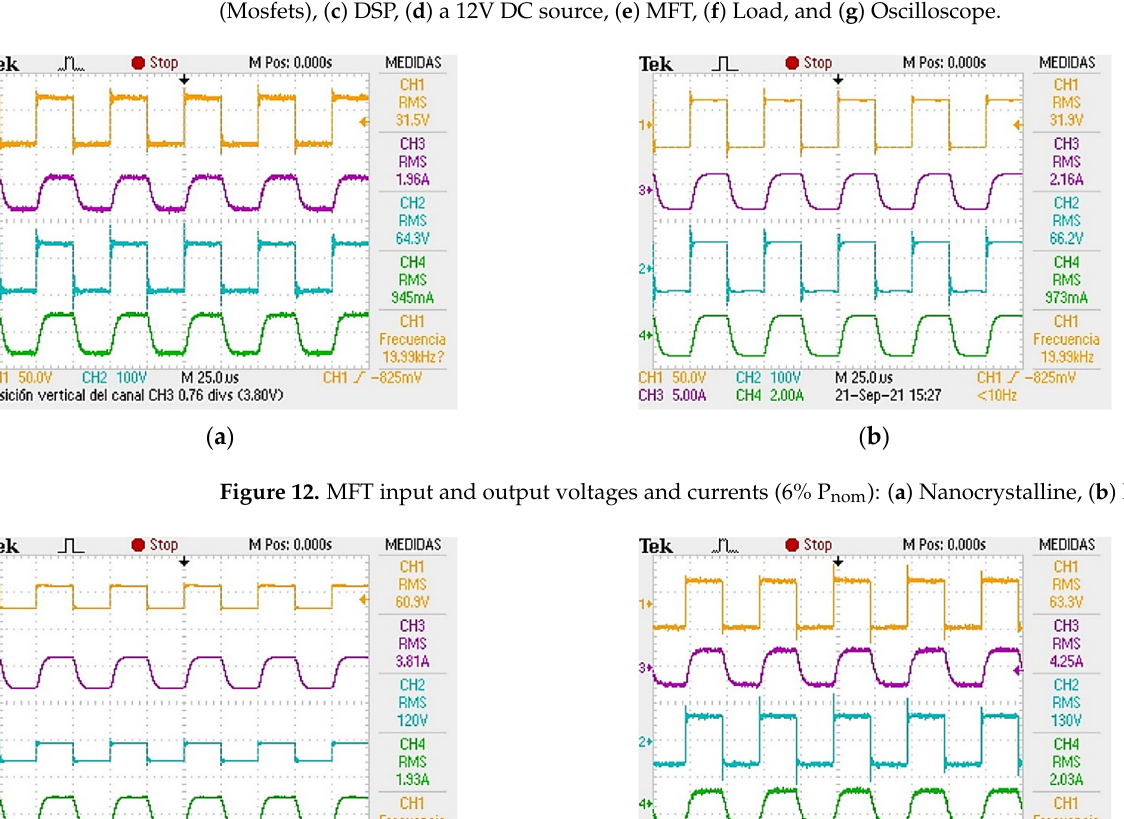
(Mosfets), ( c ) DSP, ( d ) a 12V DC source, ( e ) MFT, ( f ) Load, and ( g ) Oscilloscope.